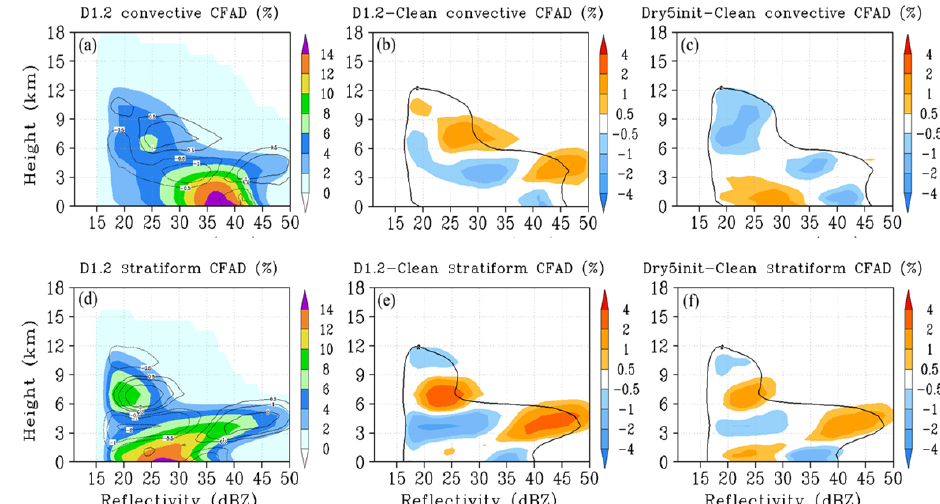
Figure 14. Contoured frequency by altitude diagrams (CFADs) of model-simulated convective (top row) and stratiform (bottom row) radar reflectivity. Columns: D1.2 case CFAD; D1.2–Clean case; Dry5init–Clean case. Dry5init case is based on the D1.2 case, but the dust layer is set to be 5% dryer at model start up. Boundary conditions are unchanged from the D1.2 case. Black contour line in difference plots represents the Clean case 2% contour